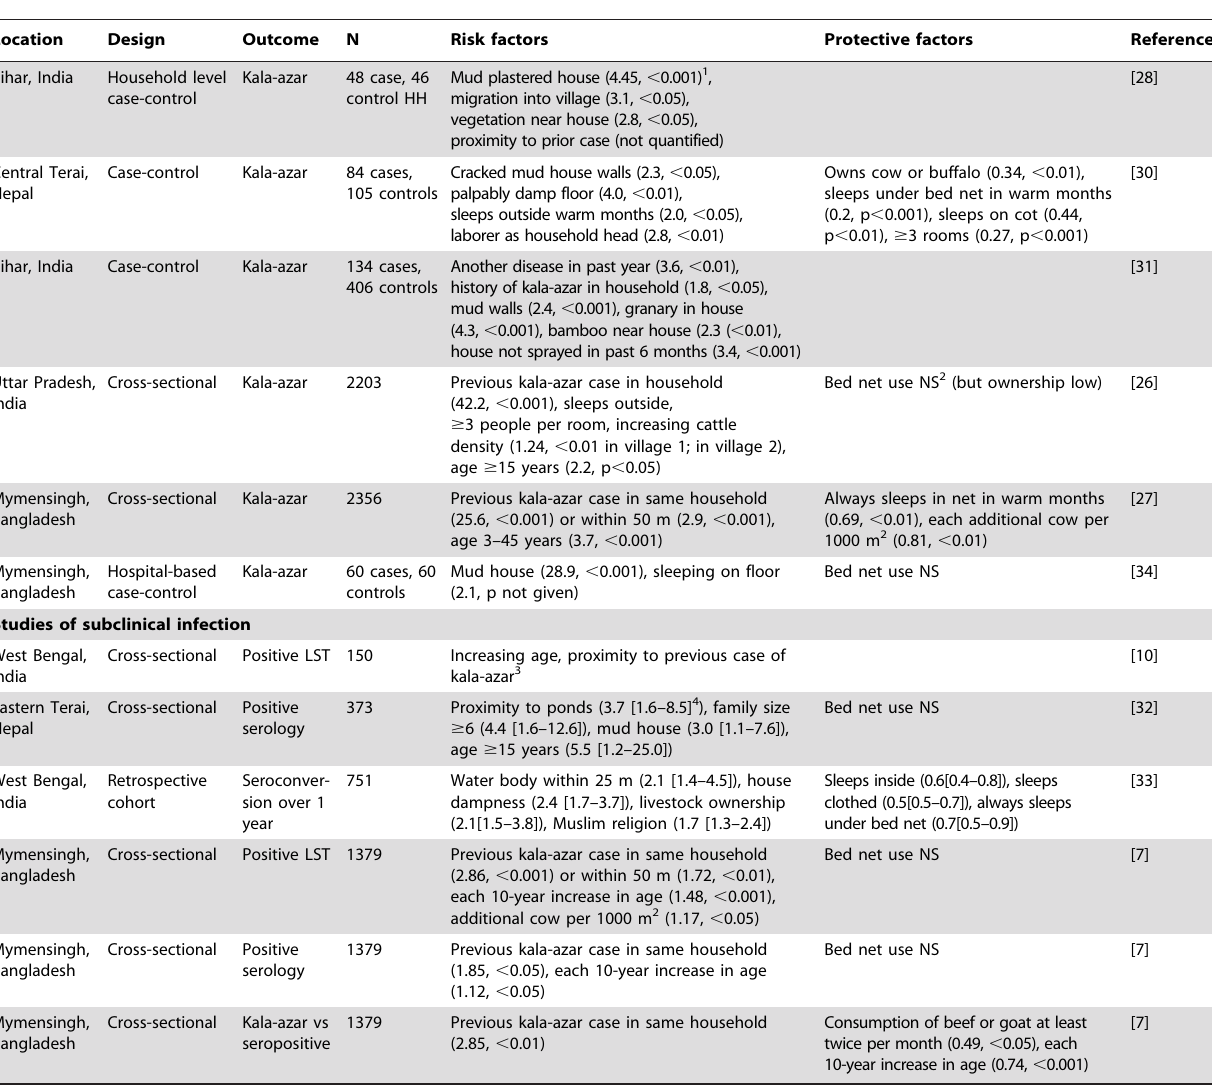
Table 1. Risk factors for visceral leishmaniasis disease and infection in South